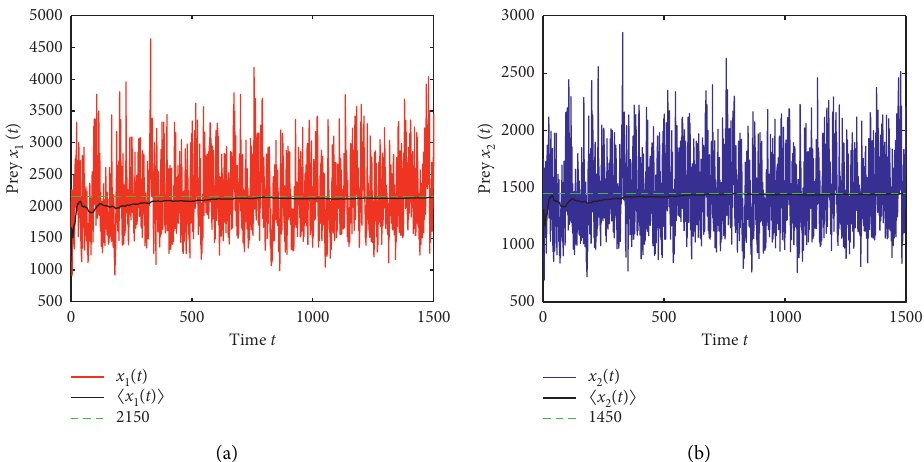
Figure 8: The trajectories of stochastic model (5) with σ 2 ( t ) and (b) prey x x 1